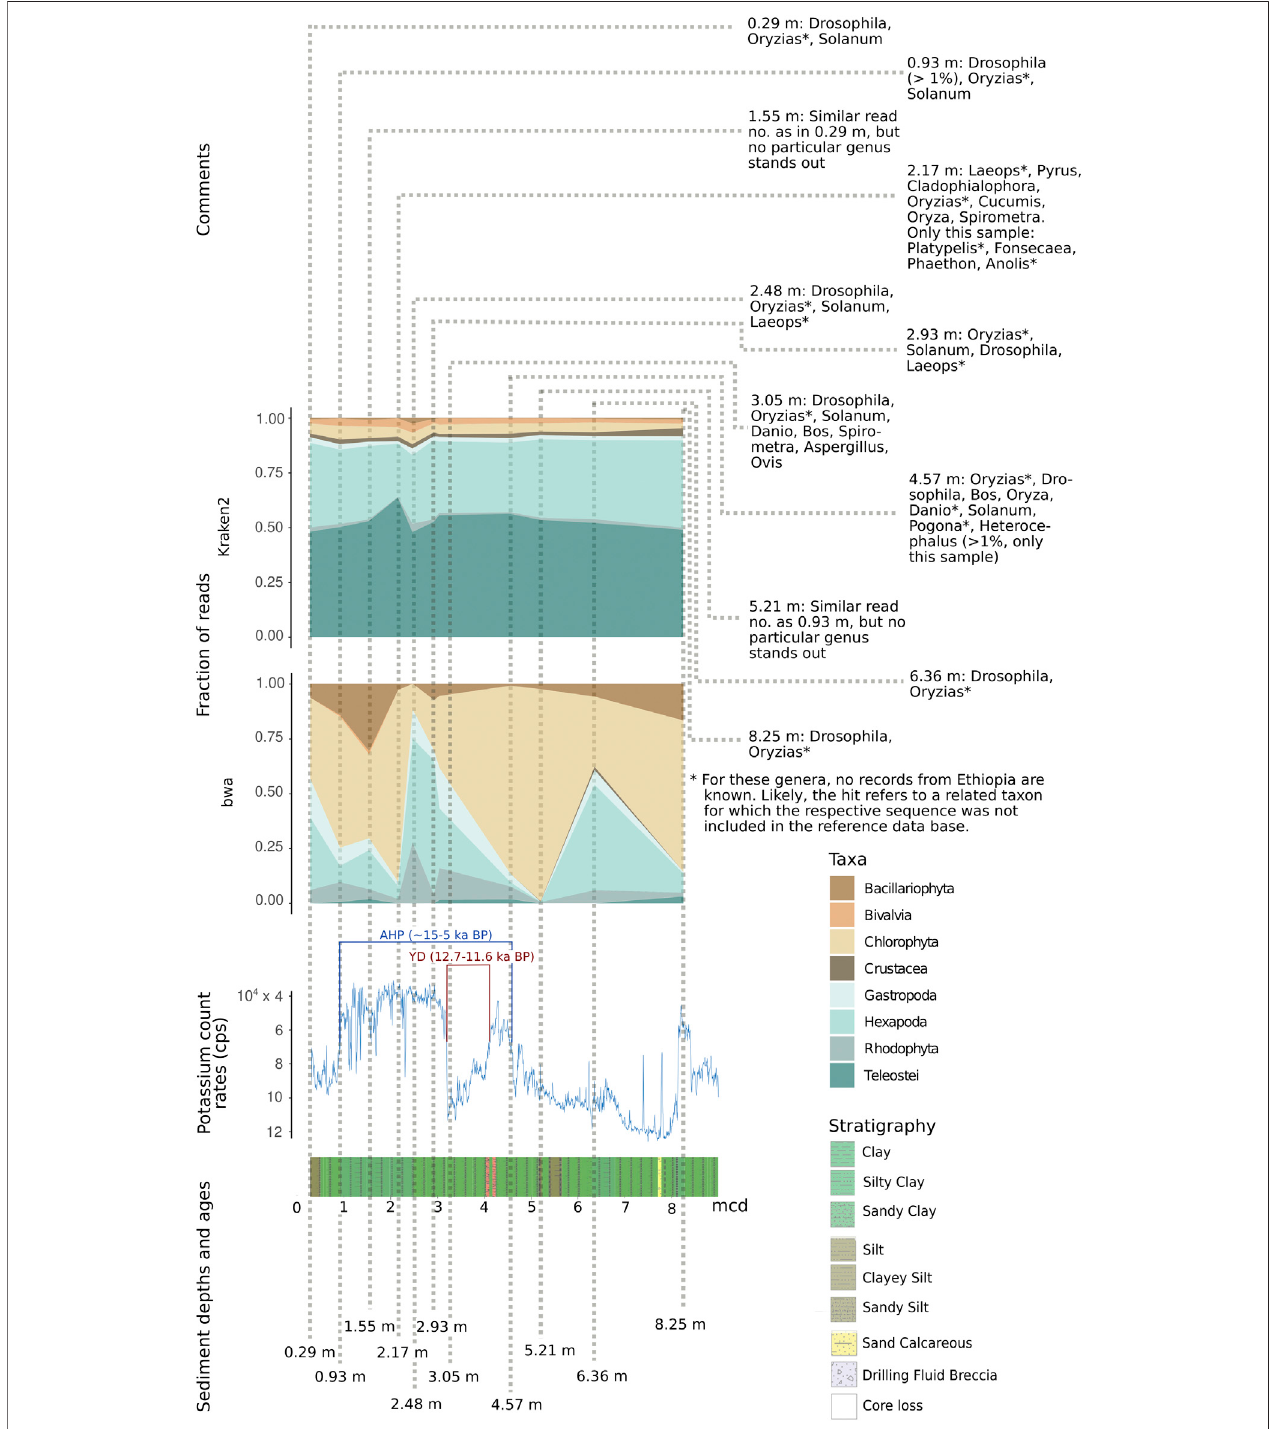
FIGURE10| RelativefractionofreadsassignedtoselectedabundanteukaryotictaxawiththetwoassignmenttoolsKraken2andbwamem,relativetodepth(inm) aswell aspotassium count rates(inverted scale) and stratigraphy intherespectivesedimentlayer. Foreach sample, themostabundanteukaryoticgeneraare depicted. AHD, African Humid Period; YD, Younger Dryas. Note that — due to incompleteness of reference databases — reads could be assigned to genera so far unreported for Ethiopia (marked *). They may refer to related taxa not included in the reference database. Potassium count rates in counts per second (cps, note that y-axis is inverted) (Trauth et al.,